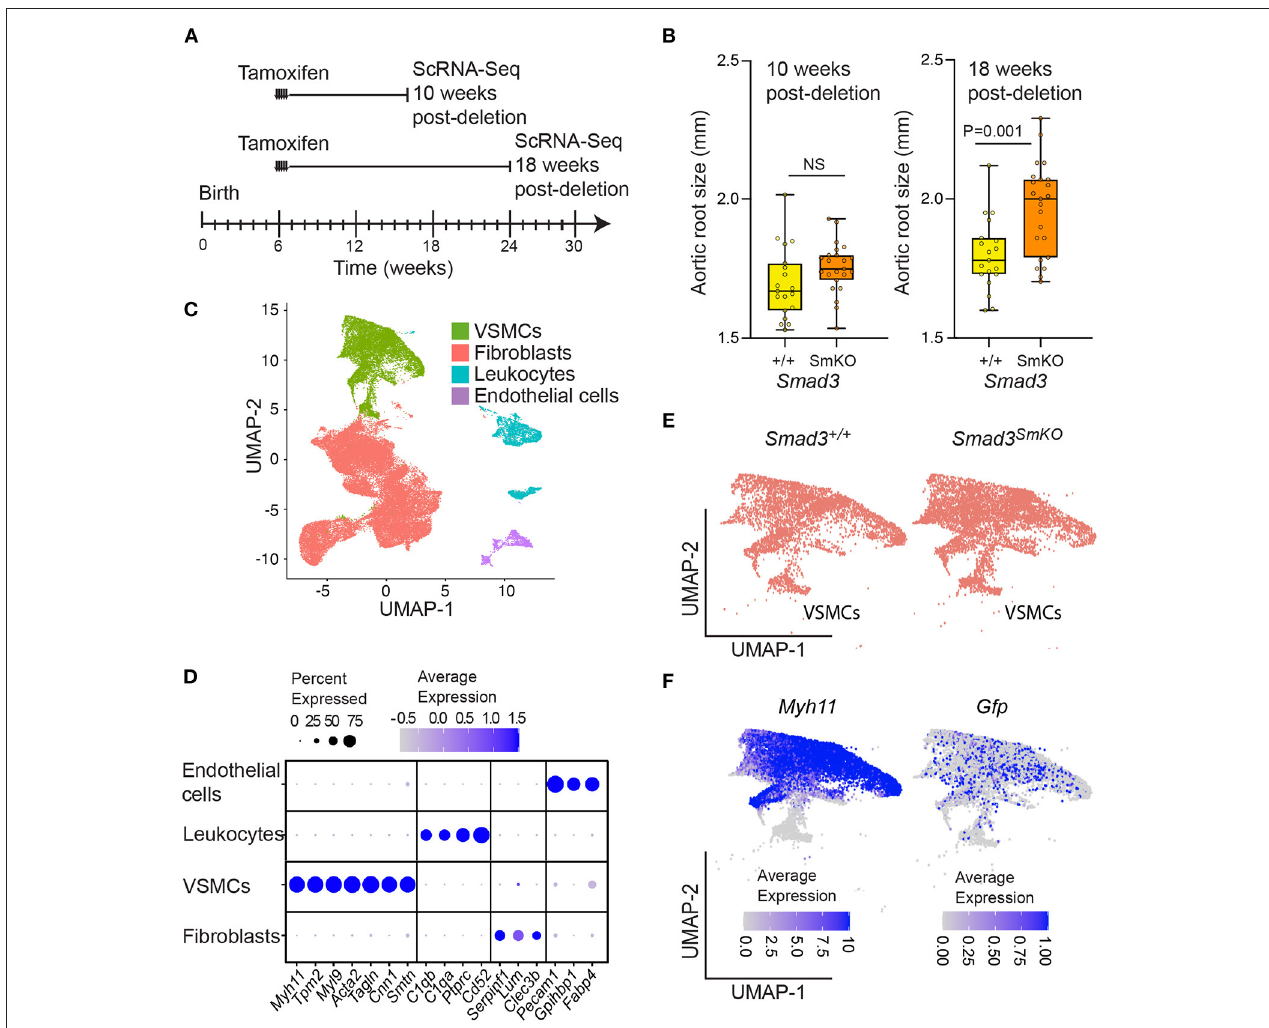
FIGURE 2 | Single cell transcriptomic analysis of control and Smad3 SmKO mice at 10- and 18-weeks post-deletion. (A) Schematic of postnatal Smad3 deletion by tamoxifen administration at 6 weeks of age and aortic tissue collection for single cell RNA sequencing at 10- and 18-weeks post-deletion. (B) Aortic root size of Smad3 SmKO mice at 10- and 18-weeks post-deletion as measured by echocardiography. P -value refers to two tailed Student’s t -test. (C) Uniform manifold projection and approximation (UMAP) of aortic cells from Smad3 + / + and Smad3 SmKO mice. (D) Dot plot showing lineage specific transcripts used to identify vascular smooth muscle cells (VSMCs), fibroblasts, endothelial cells, and leukocytes. The intensity of the dot’s color corresponds to a scaled average expression of each transcript while the size of the dot indicates the percentage of cells in each cluster that express that transcript. (E) UMAP showing the distribution of VSMCs in Smad3 + / + and Smad3 SmKO mice. (F) UMAPs showing the distribution of Myh11 - and Gfp- expressing cells within the VSMC cluster. Mice with a Gfp lineage-tracer induced by Myh11-Cre ER were included in this analysis, as such cells expressing Gfp are those that were marked by Myh11-Cre ER at the time of tamoxifen induced Cre-mediated